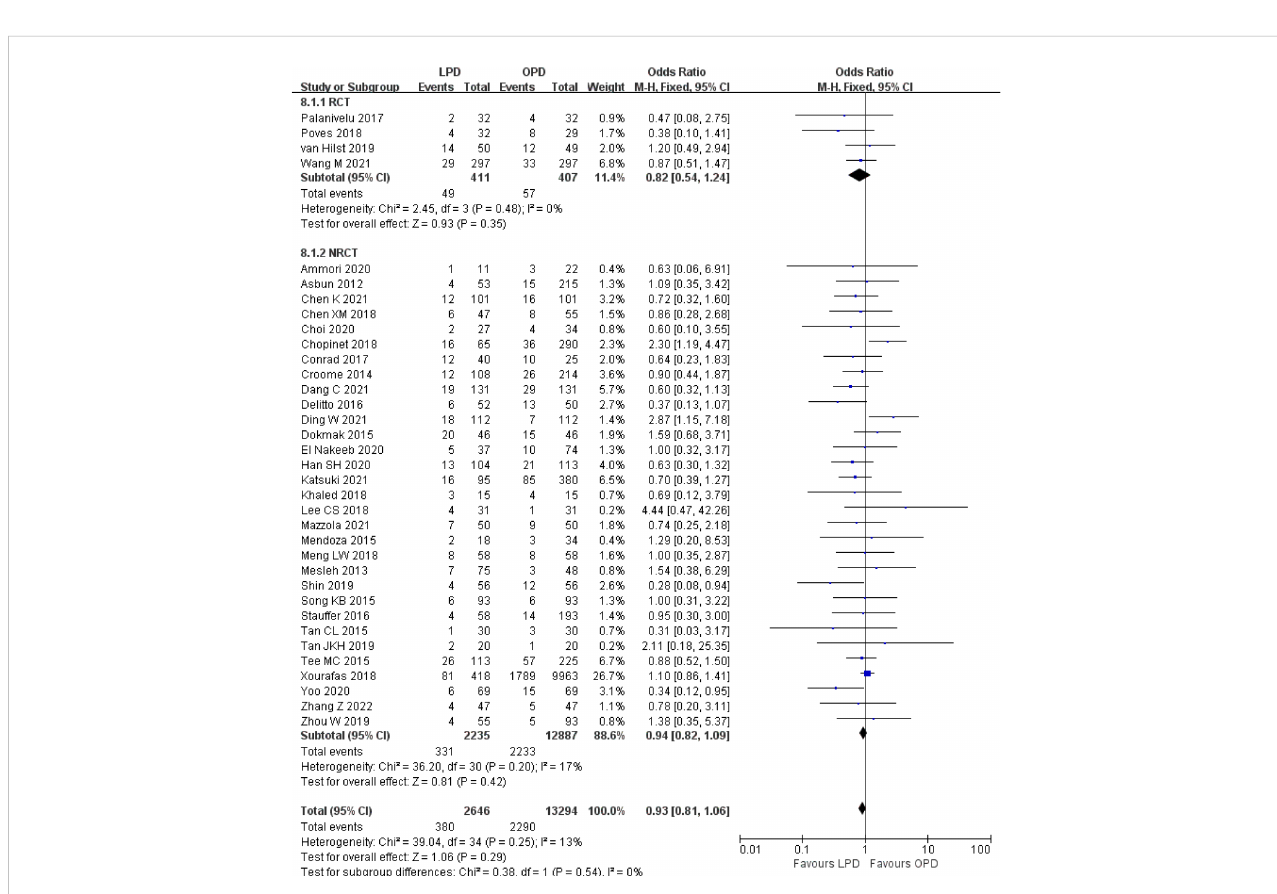
FIGURE 8 Forest plot of comparison between LPD and OPD on postoperative pancreatic fi stula. LPD, laparoscopic pancreaticoduodenectom; OPD, open